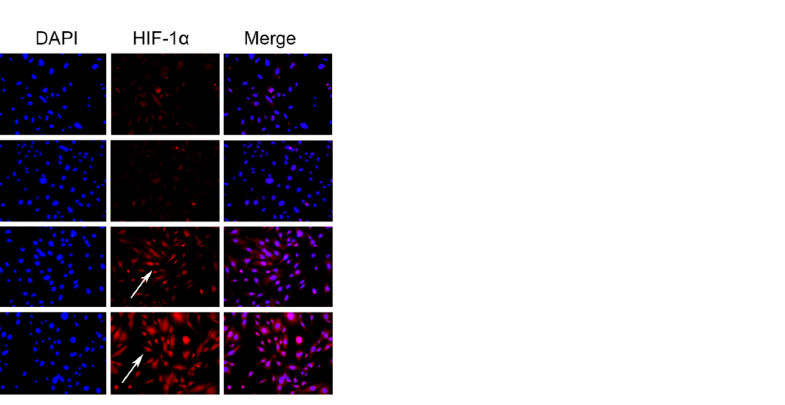
Figure 2. CoCl 2 -induced hypoxia differentially affects HIF-1 α expression in cementoblasts. ( A , B ) RT-qPCR quantification of HIF-1 α gene expression in OCCM-30 cells cultured under normoxia or hypoxia (100, 400 µ M) conditions for indicated timepoints. The relative mRNA expression of HIF-1 α was obtained through normalizing to internal PPIB. Each dot, triangle and square symbol represent a relative PD-L1 expression value. ( C , D ) HIF-1 α protein levels were determined by Western blot. Internal β -actin levels served as loading control. Quantification indicated the enhanced HIF-1 α expression in 8 to 24 h in the 400 µ M hypoxia treated group relative to the control group. Results are reported as fold change and relative the control group as 1. ( E ) Confocal microscopy analysis of subcellular localization of HIF-1 α (red) in OCCM-30 cells cultured under normoxia or hypoxic conditions for 24 h at the same initial cell density. White arrows show its cellular localization. Nuclei are stained with DAPI (blue). Individual and merged images of HIF-1 α and DAPI are shown. Scale bar: 100 µ m. The blots and photomicrographs represent three independent experiments with SD. Statistically significant differences (indicated by asterisks) are indicated as follows (ns, no significant difference; * p < 0.05; ** p <